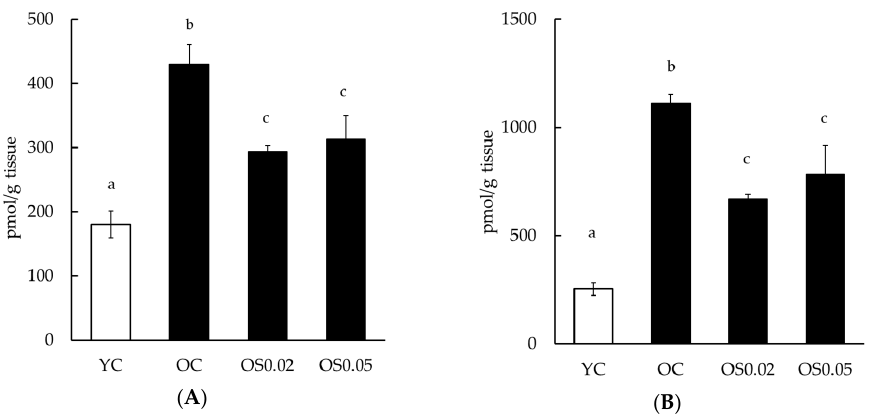
Figure 5. 4-hydroxy-2-nonenal (HNE) ( A ) and 4-hydroxy-2-hexenal (HHE) ( B ) in cerebral cortices obtained from mice in the YC, OC, OS0.02, and OS0.05 groups ( n = 5). Experimental groups are indicated as: Young control, fed basal diet (YC), old control, fed basal diet (OC), old, fed basal diet supplemented with 0.02% sesame lignans (OS0.02), and old, fed diet supplemented with 0.05% sesame lignans (OS0.05). Statistical analyses were performed using a one-way ANOVA followed by a Tukey–Kramer post hoc analysis. Different letters indicate significant differences ( p < 0.05). The retention times for HNE and HHE were 10.42 min and 8.36 min, and the m / z information for HNE and HHE were m / z 362 and m / z 404,